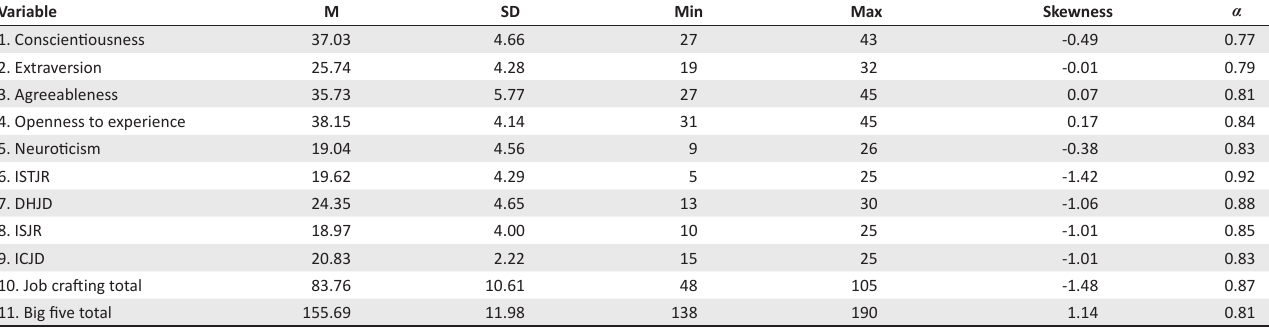
TABLE 3: Descriptive statistics and reliability statistics for the scales. Variable